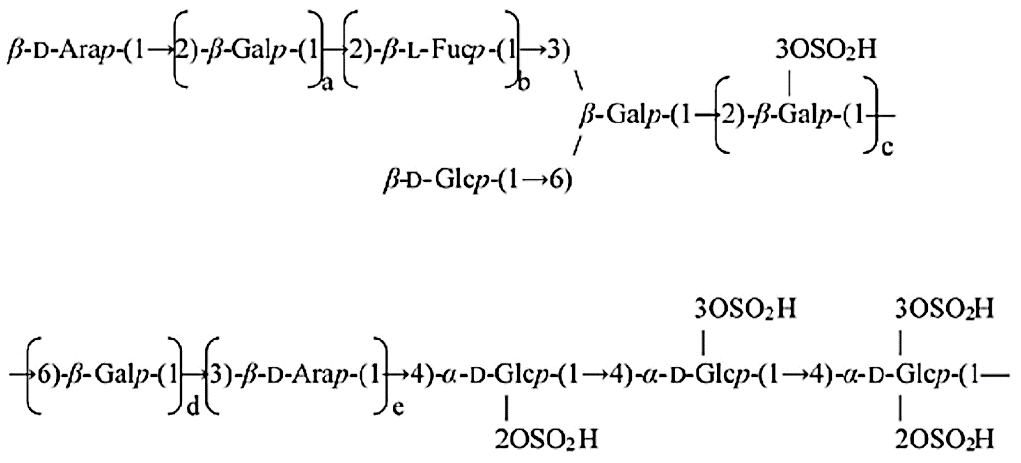
Figure 1. Proposed chemical structure of PPA.